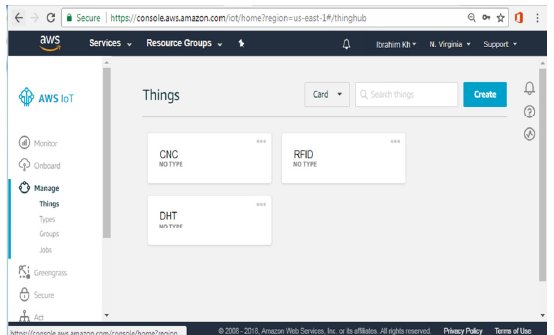
Fig. 6. AWS cloud connection with CNC and